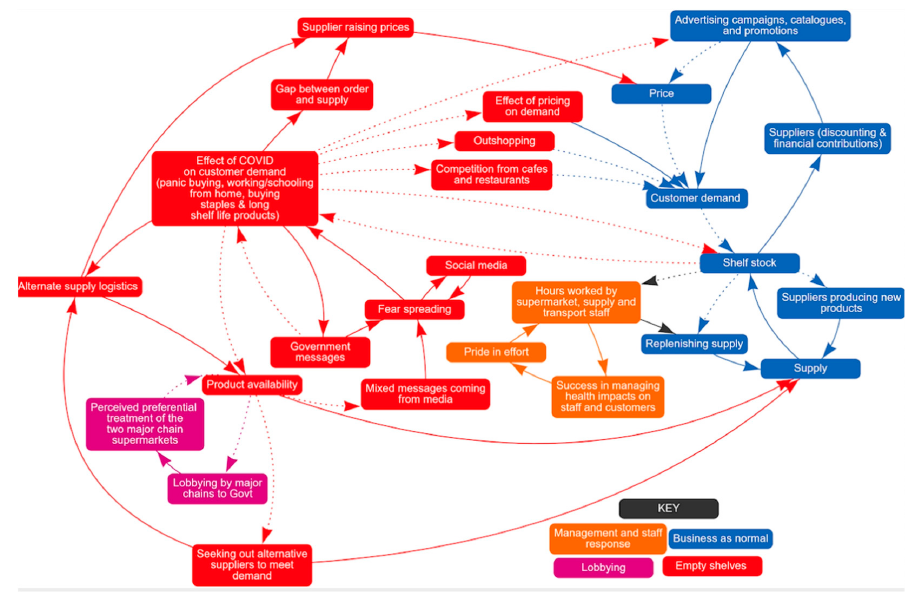
Figure 1. Factors influencing food supply and demand: supermarket retailers’ perspective.